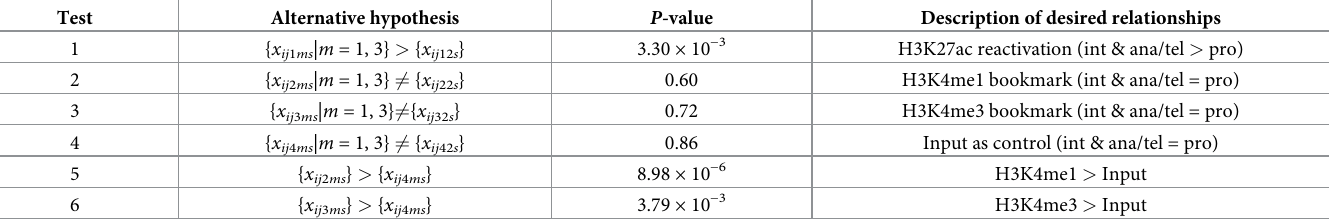
Table 2. Hypotheses for t tests applied to histone modification in the selected 507 DNA regions. The null hypothesis was that the inequality relationship of the alterna- tive hypothesis is replaced with an equality relationship. int: interphase, ana: anaphase, tel: telophase, pro: prometaphase. Test